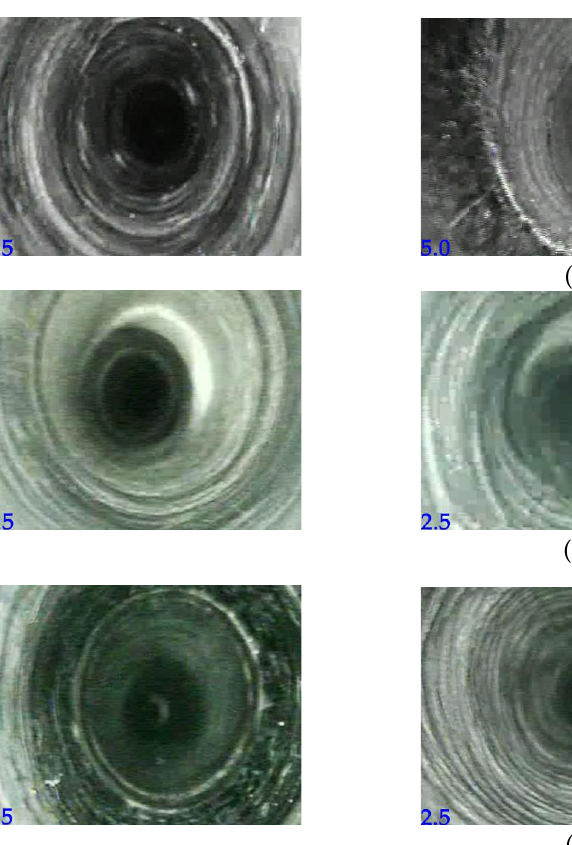
Figure 10. The main roadway-surrounding rock observations via peep boreholes (Unit: m): ( a ) roof; ( b ) two walls; ( c ) floor.